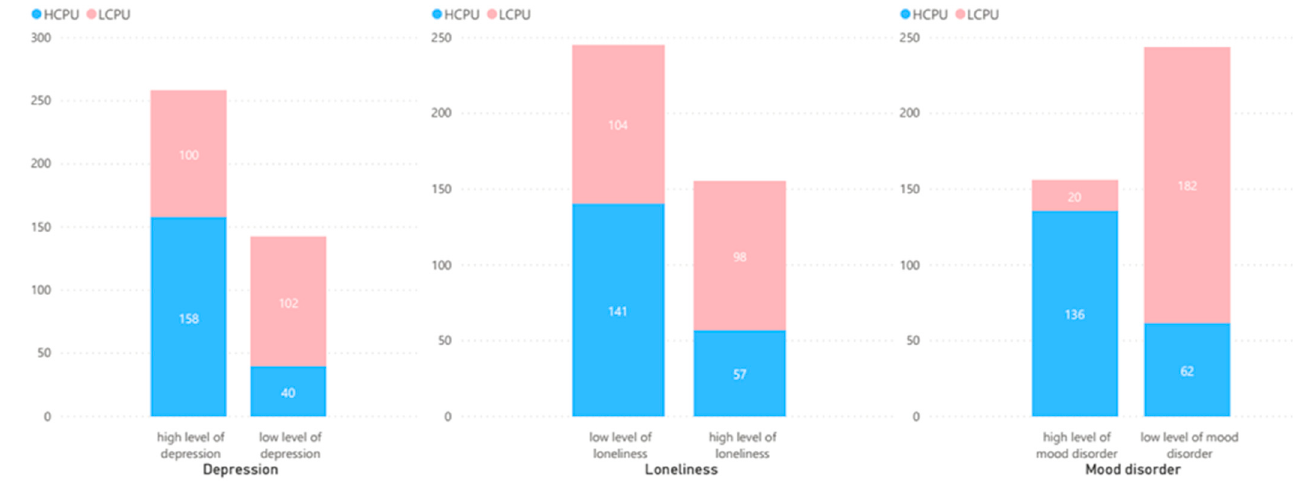
Figure 2. Proportion of depression, loneliness and mood disorder based on LCPU and HCPU.